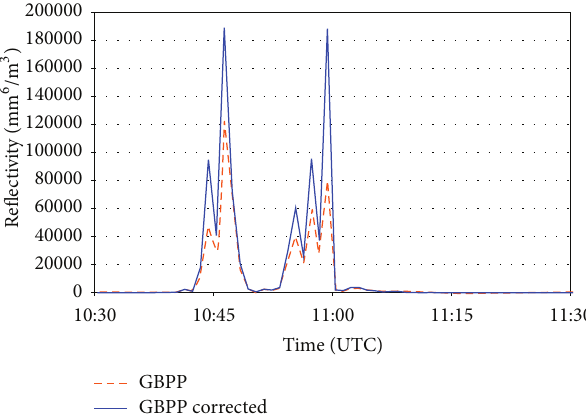
Figure 12: Reflectivity factors calculated with the sampling area uncorrected ( GBPP ) and corrected ( GBPP corrected ) during the most intense rainfall